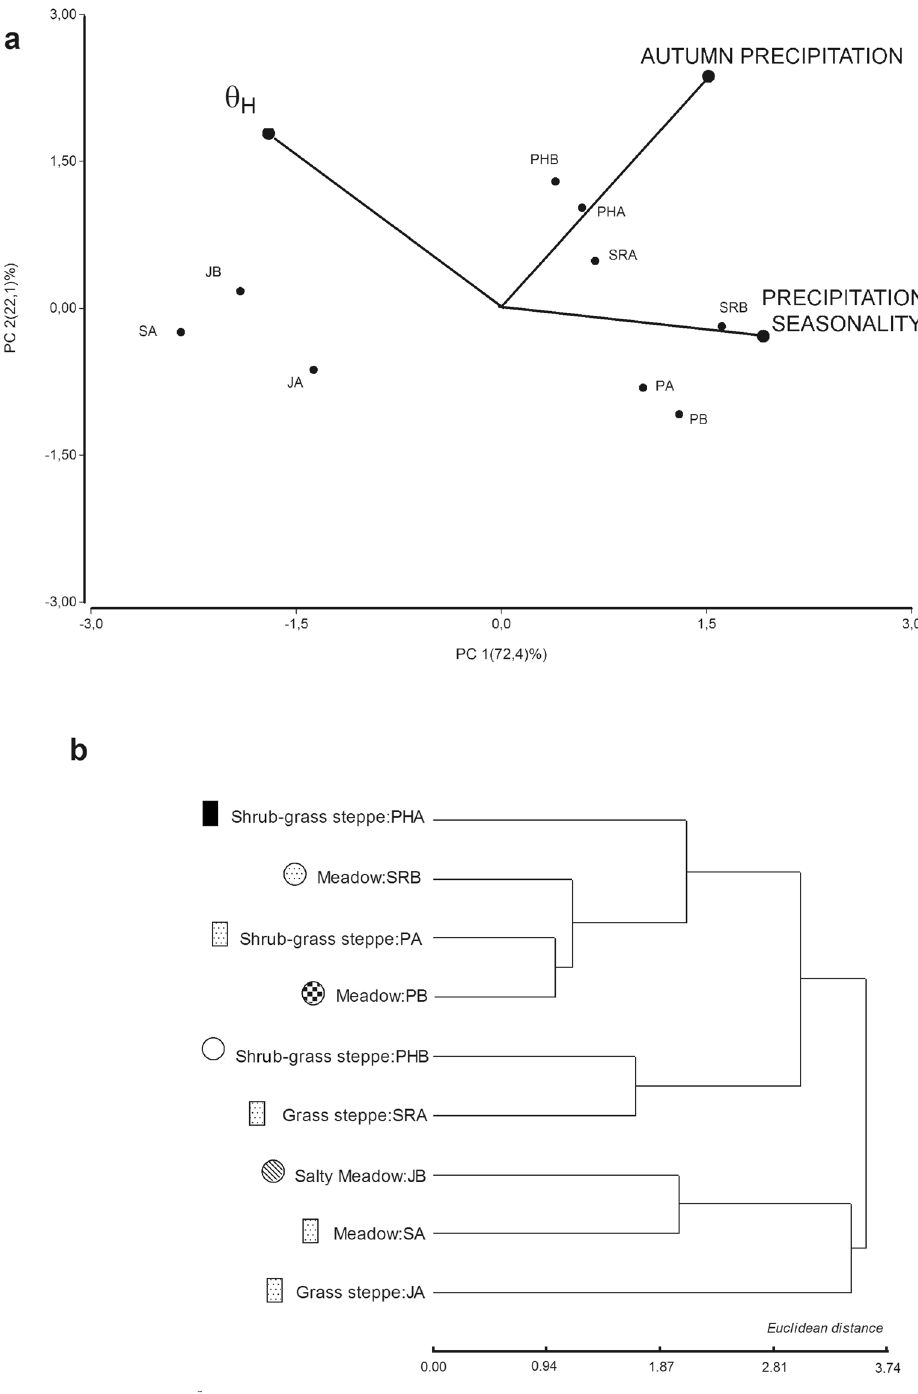
Figure 2. Principal Component Analysis of environmental variables and hydrotime model parameters ( a ) and Dendrogram based on a hierarchical clustering method with environmental and physiognomic characteristics of each sampled site ( b ). Symbols represent the different types of soil as described in Table